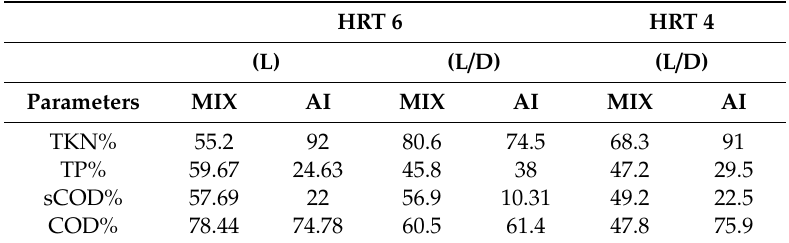
Table 3. Analyses of the sequencing batch reactor e ffl uents using a two-agitation mode (AI / MIX) for 6 and 4 days HRT under di ff erent